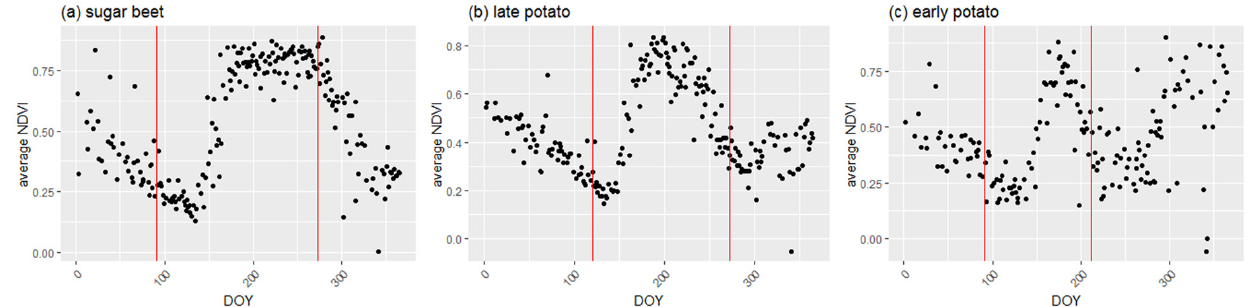
Figure 2. Average NDVI for ( a ) sugar-beet fields (468 fields), ( b ) late-potato fields (685 fields) and ( c ) early-potato fields (38 fields) from 2016–2018. The vertical red lines indicate the start and end DOY (day of year) used for the calculation of aNDVI: 91–273 for sugar beet (from the beginning of April to the end of September), 121–273 for late potato (from the end of April to the end of September), and 91–212 for early potato (from the beginning of April to the end of